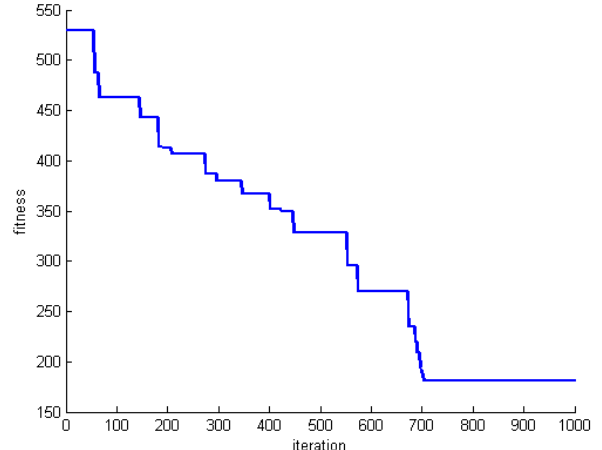
Figure 5. The fitness of the best whale during whales’ motion in DS 1 .